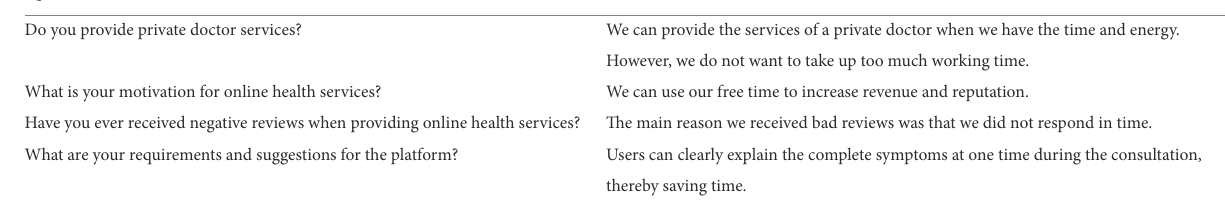
TABLE 5 Examples of survey questions and interview